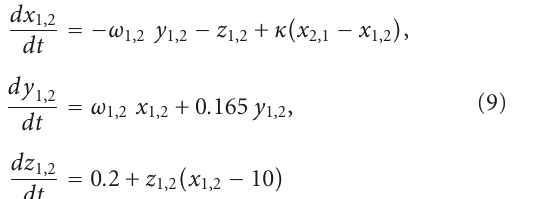
(cf. Figure 2) the averaged coincidence rate (cid:8) C (cid:9) , obtained from averaging C -values from the seizure-free periods